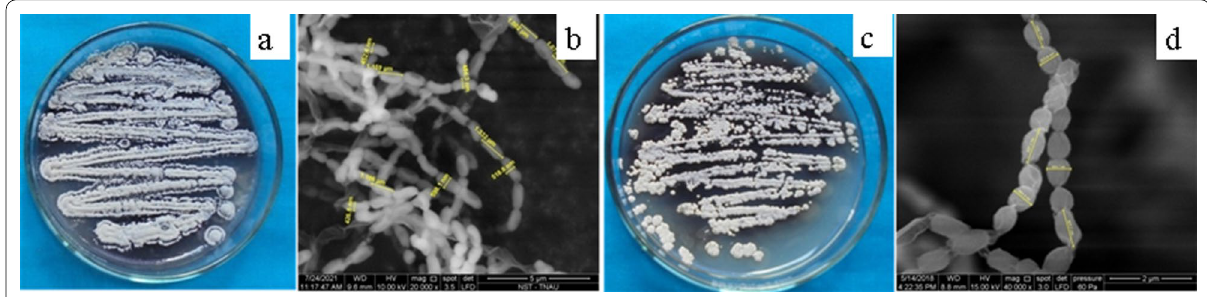
Fig. 3 Morphological characterization of potent isolates. a M11, b ESEM of M11, c M12, d ESEM of M12